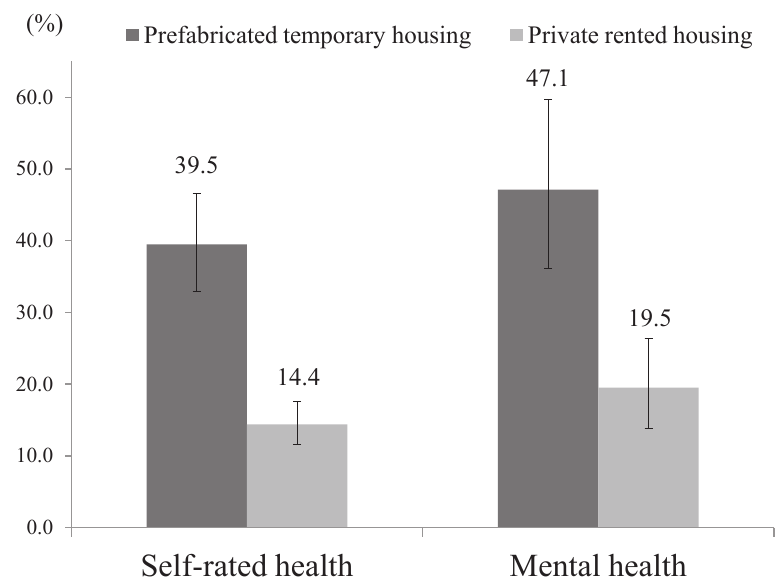
Figure 1. Population attributable fractions (PAFs) of social participation for good self-rated health and good mental health. Population attributable fractions present the contributions by social participation for good self-rated health and good mental health. Overall, the PAFs of social participation di ff ered and were higher in the prefabricated housing